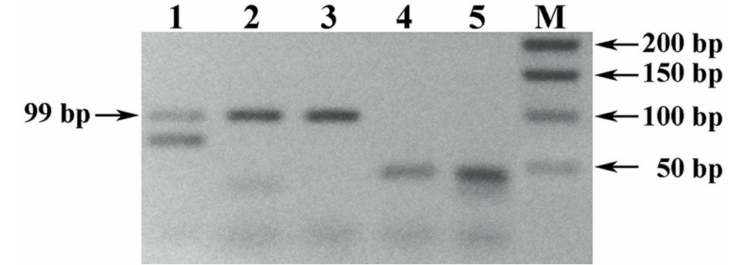
Figure 6. Electrophoregram of the result of PCR amplification of the Vitis vinifera L. UFGT gene locus with UFGT-F1 and UFGT-R1 primers for reproducibility of the reaction. Legend: (1–2) PCR of a DNA sample extracted with “DNA-sorb-S-M kit”: from the precipitated debris of white wine Visigodo Sauvignon blanc, sampled with a 1-day exposure in a mixture with PVP, sodium acetate and isopropanol. (3–4) PCR of a DNA sample extracted with “DNA-sorb-S-M kit” from the precipi- tated red wine debris Lagar De Robla (Mencia), sampled by a 10-min exposure in a mixture with PVP and isopropanol. (5) Negative control sample. M) DNA size markers 50+ bp (Evrogen